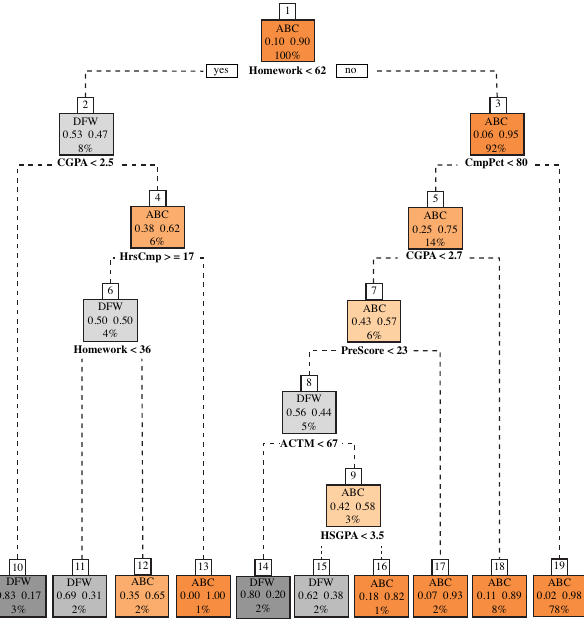
FIG. 3. Decision tree for predicting the DFW outcome for sample 2 using institutional data and data available in class at the end of week